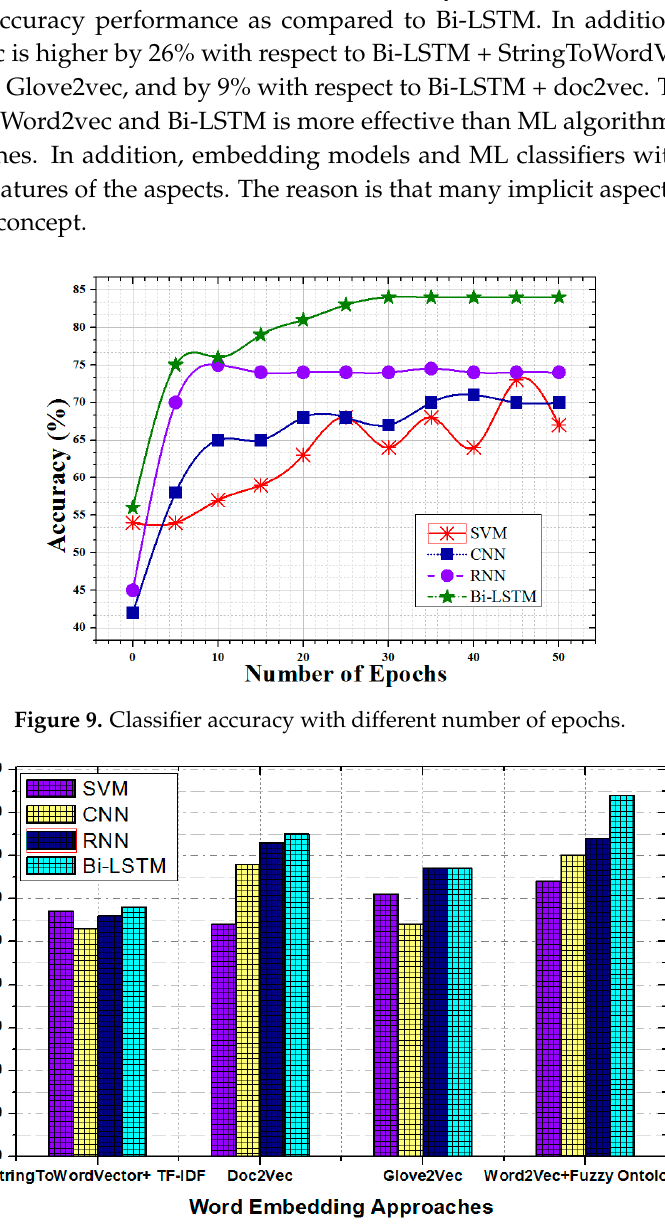
Figure 10. Classification accuracy of different baseline models with word embedding models.